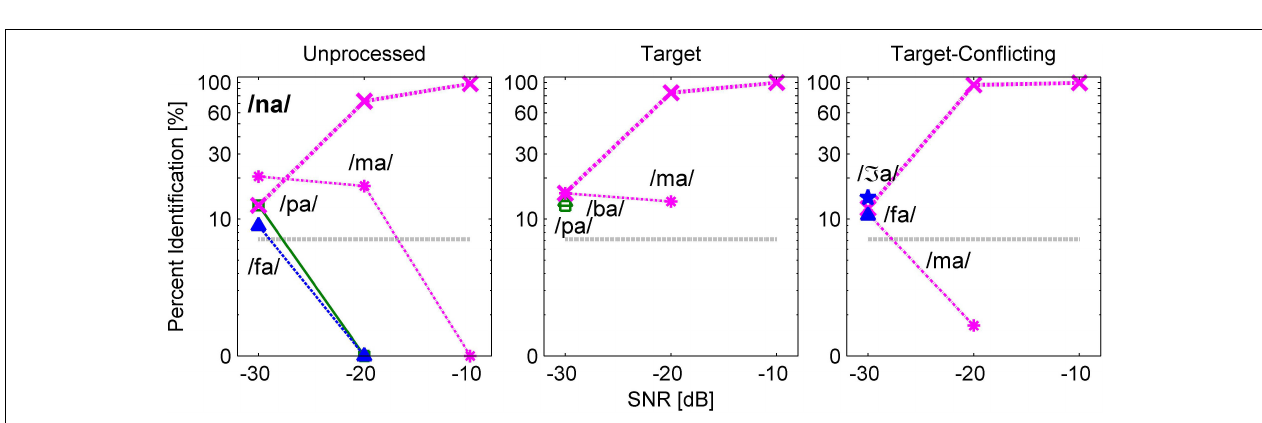
FIGURE 7 | Confusion patterns when /ma/ was presented. A description for the figure is the same as presented in Figure 6 .